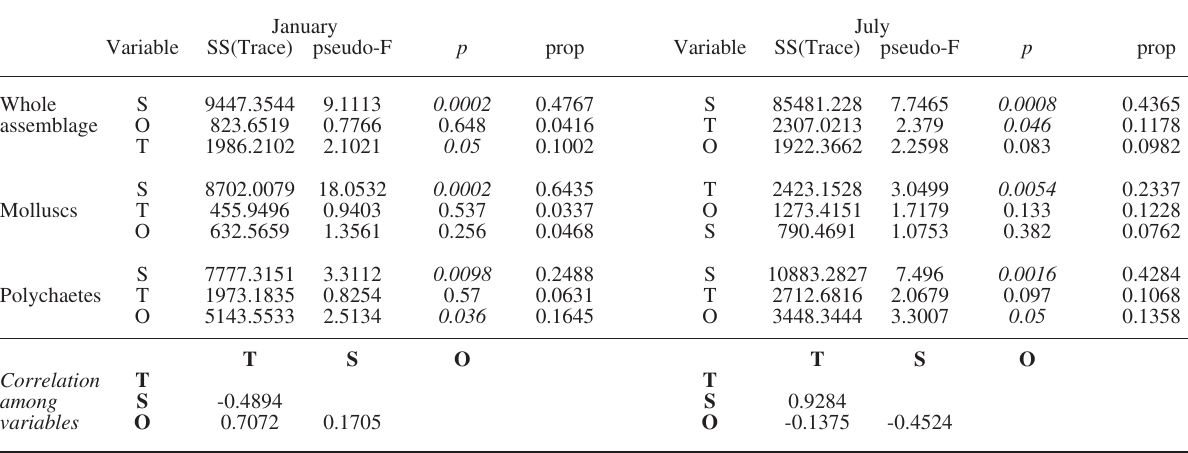
Table 3. – DISTLM-forward analysis: results of the forward selection procedure. SS(Trace) = portion of sum of squares relative to the analysed predictor variable; pseudo-F = statistic; p = significance level (in italics the significant p values); prop = proportion of variation explained (salinity = S, temperature = T, oxygen saturation = O).